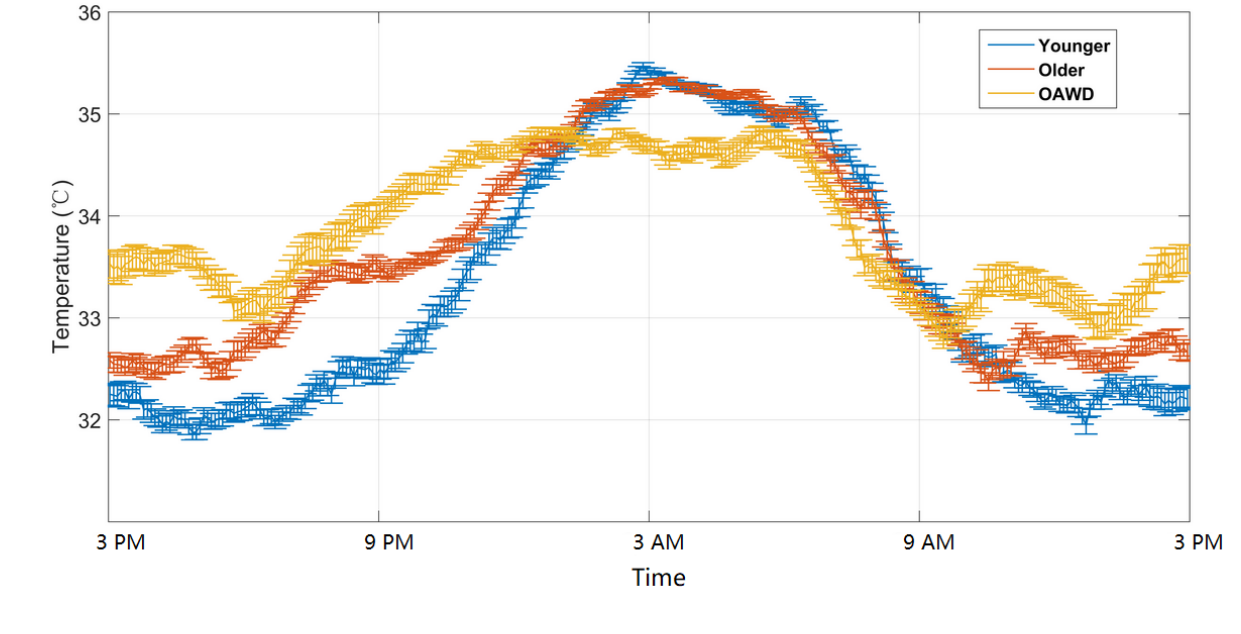
Older adults living with de-